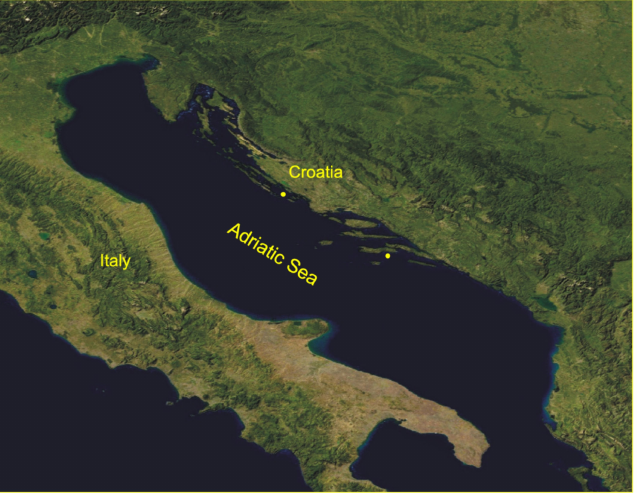
Figure 1. Map of Calappa granulata sample localities (yellow dots) in the central eastern Adriatic